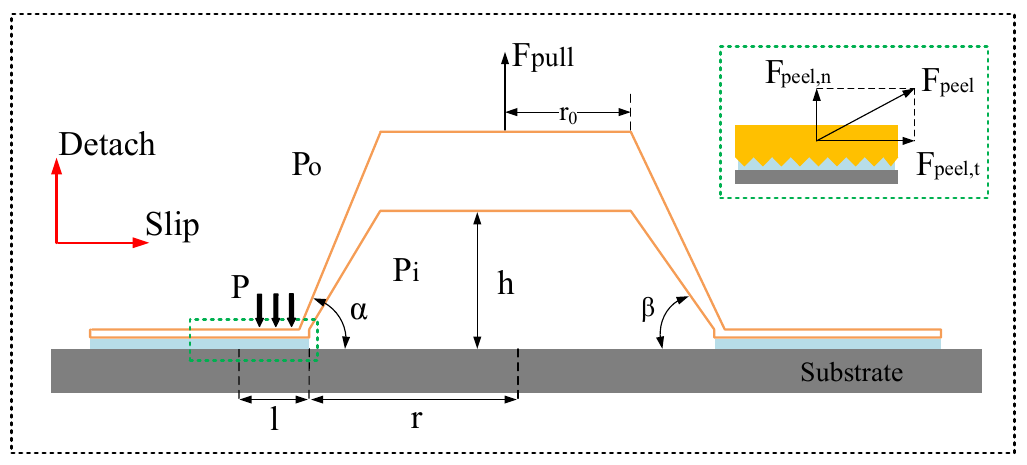
Figure 12. Model of the bioinspired disc.